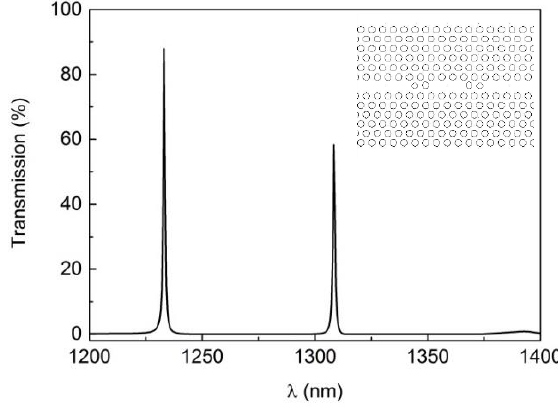
Figure 7. Simulated transmission spectra. Inset: sketch of the chosen design.